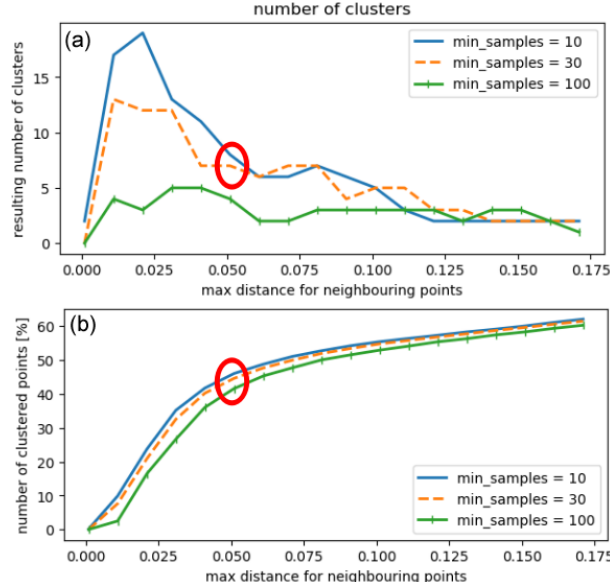
Figure 11. DBSCAN selection of input parameters: number of clusters versus input parameter maximum distance within clusters, and minimum number of points and percentage of total points in clusters (not classified as noise or outliers). The choice of an “op- timal” set of parameters is not obvious. We indicate our selection with a red circle in both